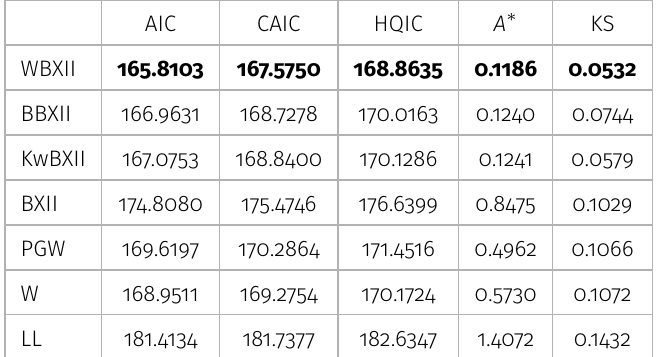
Table VI. Goodness-of-fit statistics for the fits to the turbochargers failure time data.